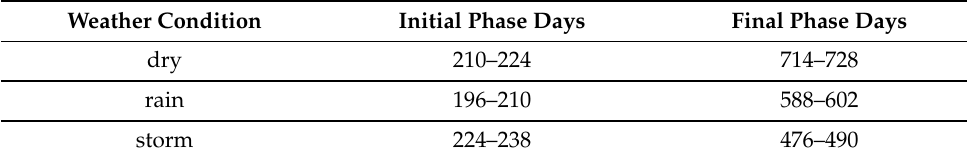
Figure 9. Days on which the RL agent and the PIDs will be compared. Table 2. Comparison